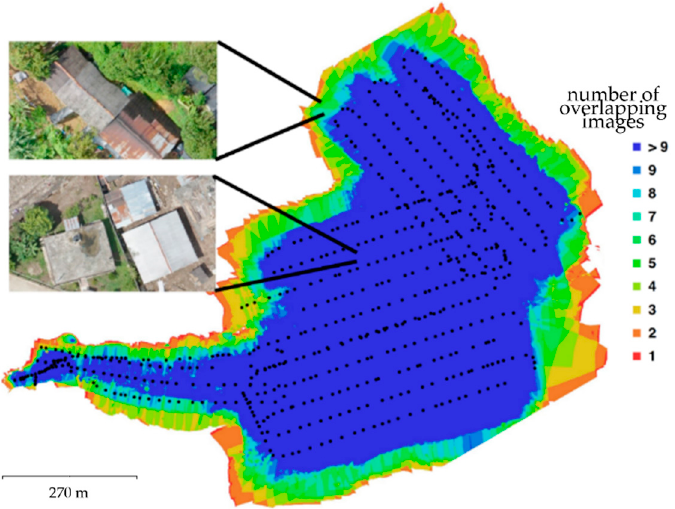
Figure 5. The location and superposition of images after photogrammetric restitution. Upper picture: misaligned picture; and lower picture: aligned picture.